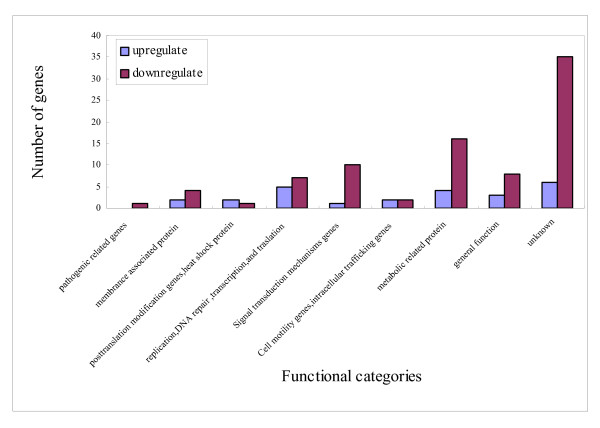
functional categories. Genes differentially expressed at 37°C and 28°C, grouped by functional classification according to the NCBI L. interrogans 56601 COGs database . Genes were regarded as differentially expressed when the expression levels differed by at least twofold. The number of upregulated (red bars) and downregulated (blue bars) genes in each functional group is shown.